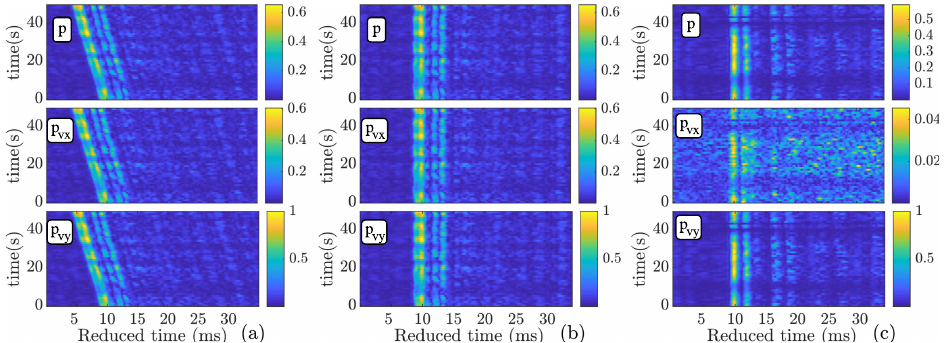
Figure 7. Estimated CIR for stations 3 ( a , b ) and 6 ( c ) for pressure ( p ) and pressure-equivalent particle velocity ( p vx and p vy ) (from top to